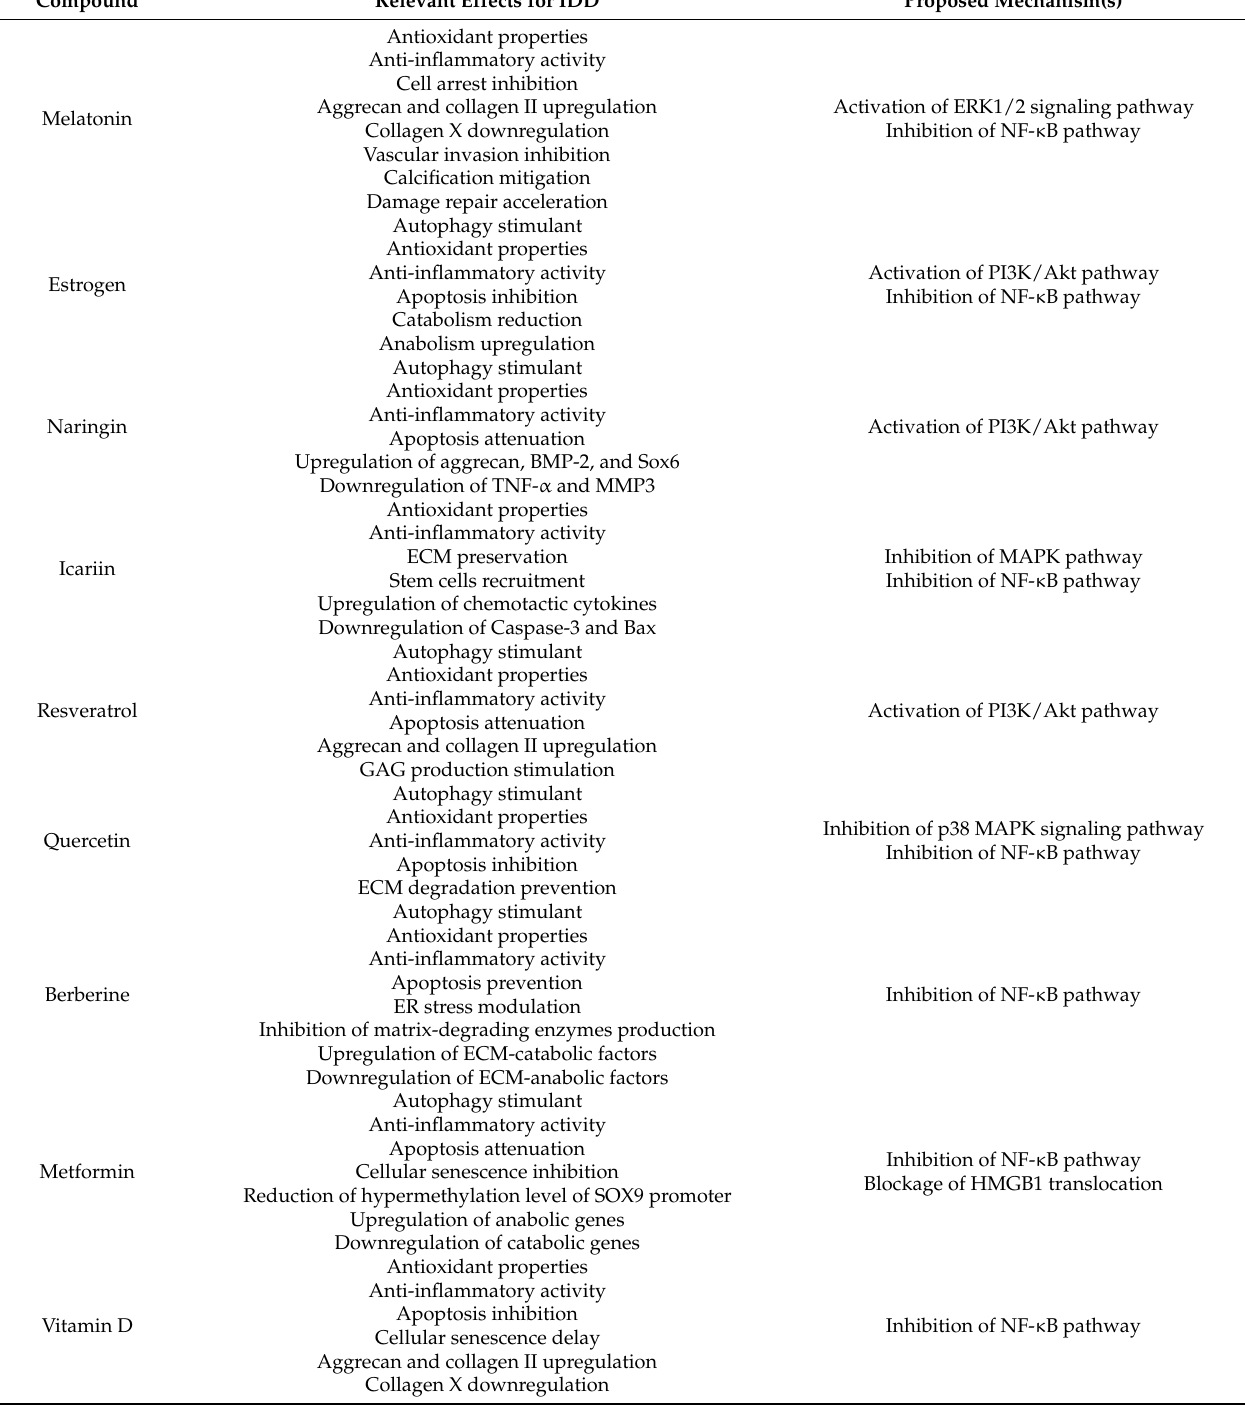
Table 1. Summary of key compounds for intervertebral disc degeneration (IDD)